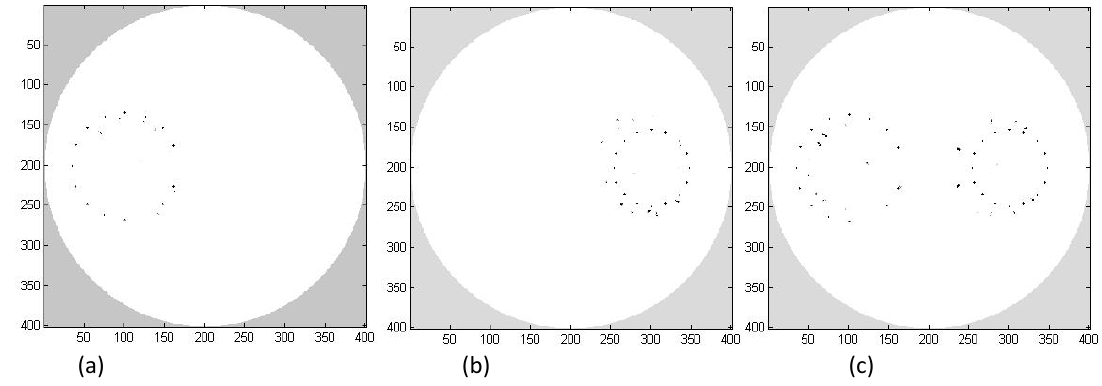
Figure 8: Reconstruction images of ultrasound reflection. (a) Rubber cylinder in the left side, (b) Aluminium cylinder in the right side, and (c) Rubber and Aluminium cylinder in the left and right side.